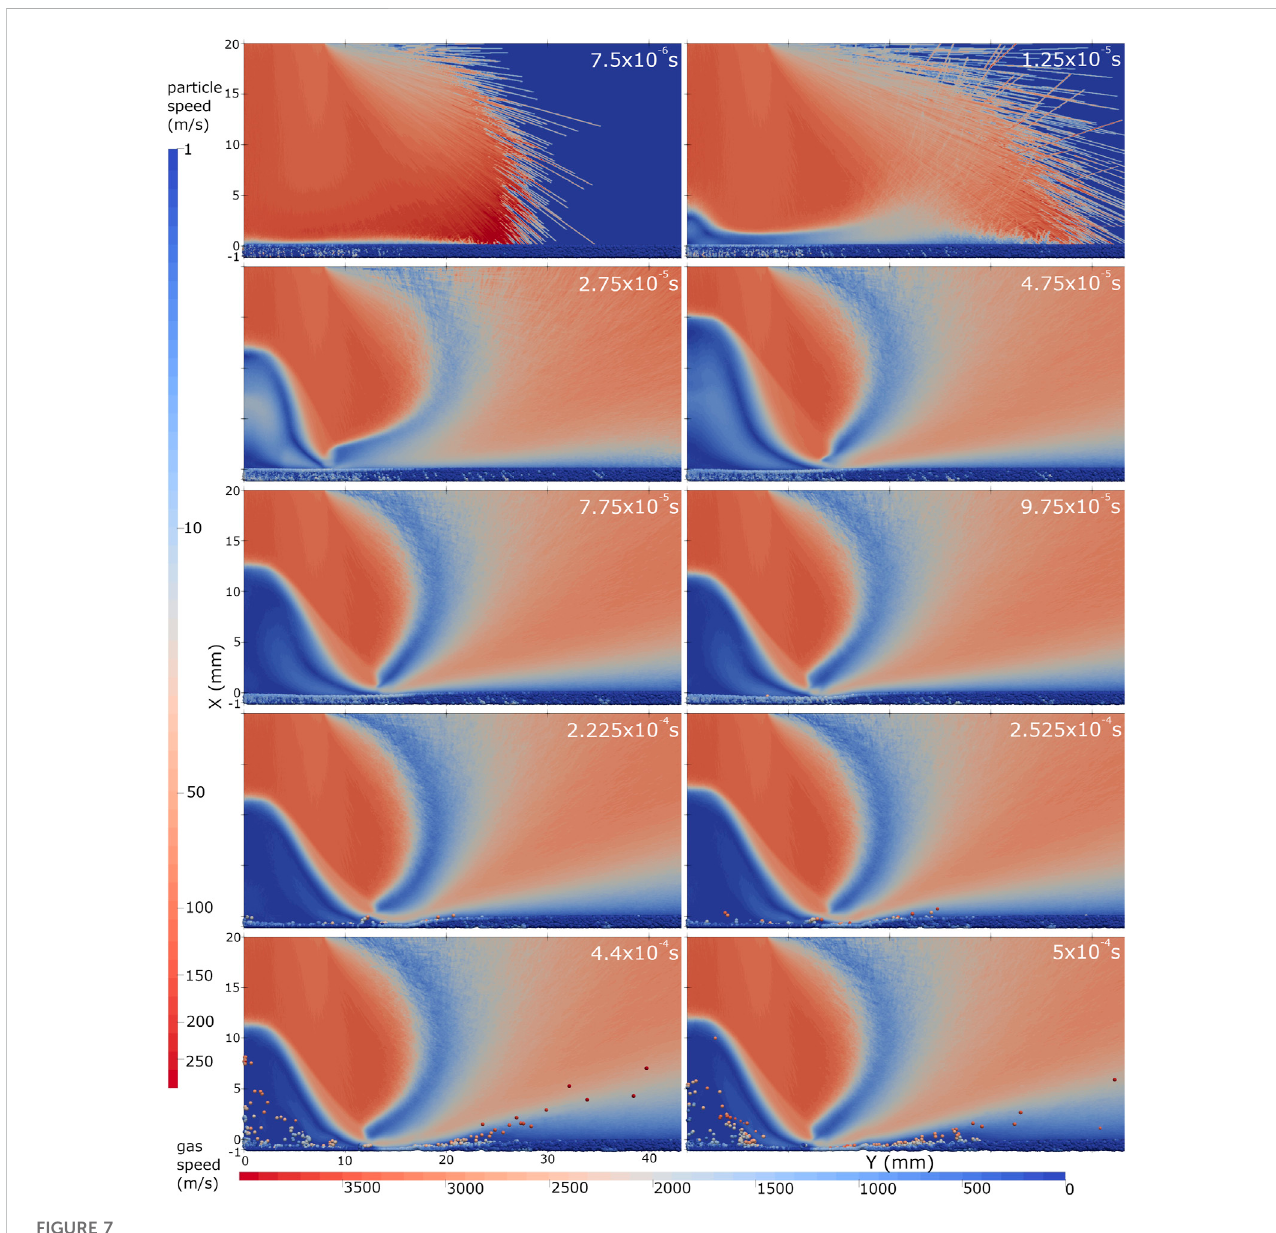
Overview of the two-phase fl ow evolution with the MPPIC